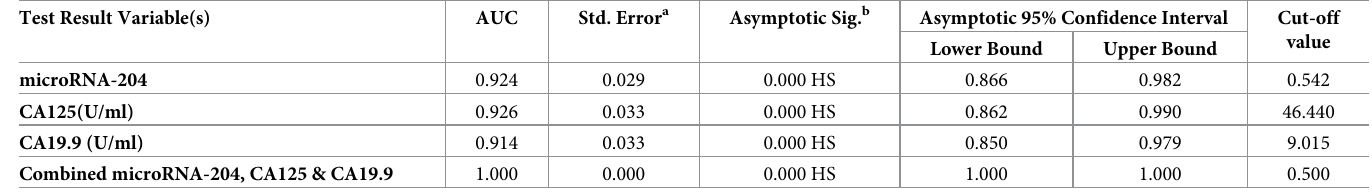
Table 4. Area under the curve (AUC) and a cut-off value of microRNA-204, CA125, CA19.9, and combined microRNA-204, CA125, and CA19.9 in early ovarian cancer